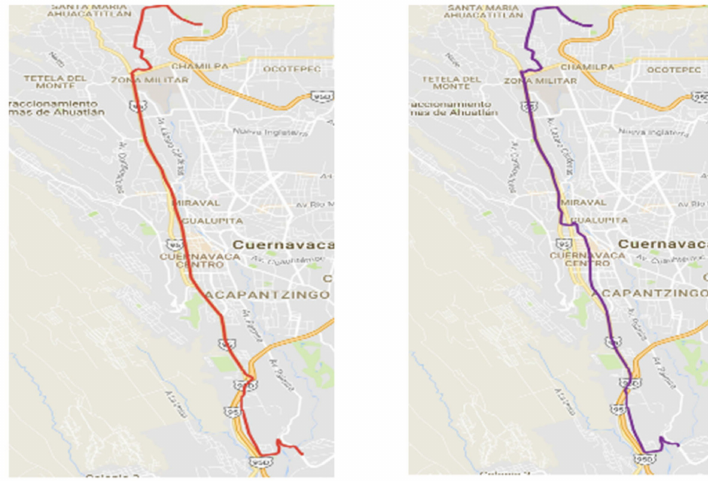
Figure 18. Design of the route used for